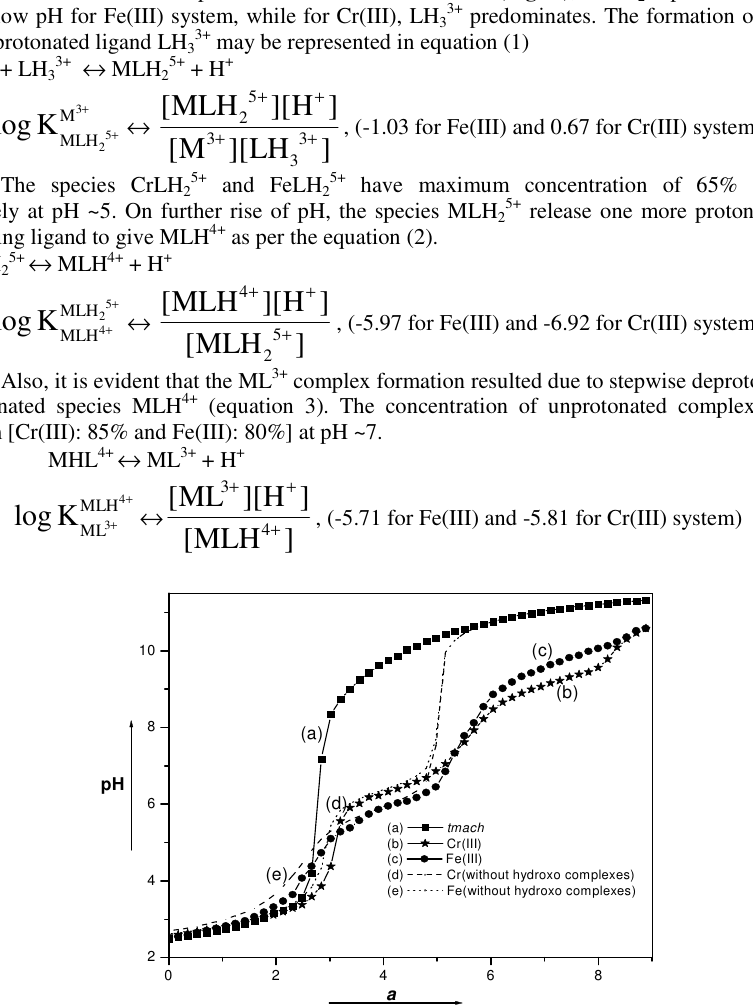
Fig. 2. Potentiometric titration curves of tmach (L) with Fe(III) and Cr(III) in 1:1 molar ratio, where ‘ a’ is the moles of base added per mole of ligand present. Symbols and solid lines indicate the experimental values and simulated results